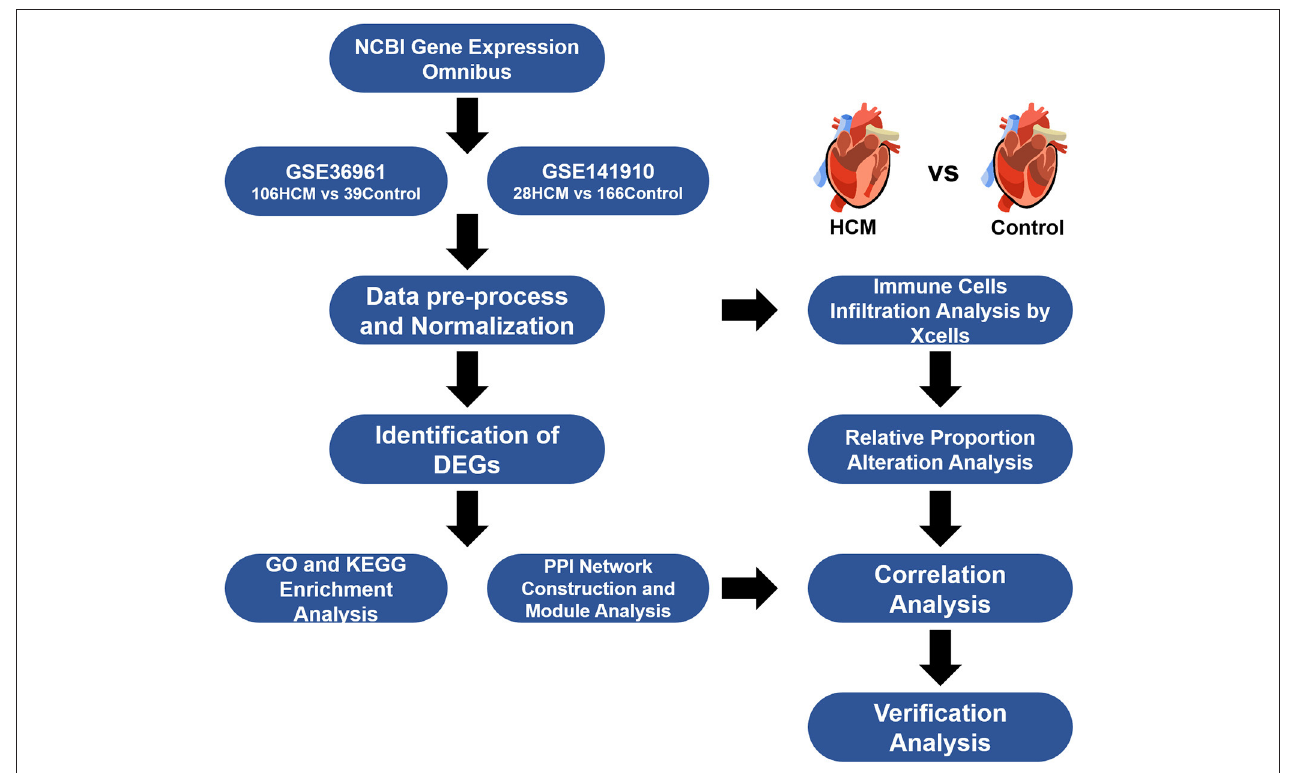
FIGURE 1 | Workflow of the